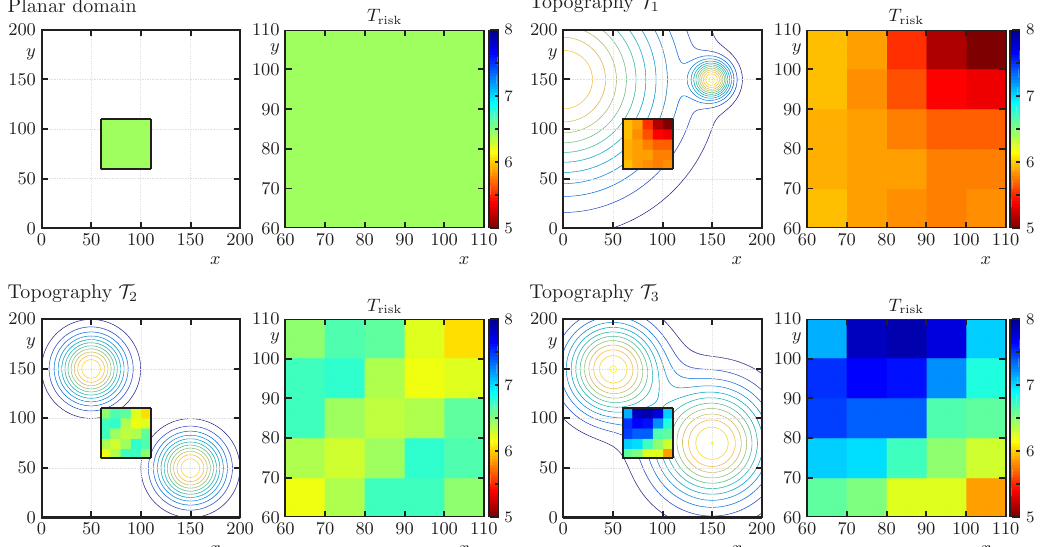
[ 60,110 ] under the assumption of × , , and (Scenarios 3.2 to 3.4, T 1 T 2 T 3 10 the final time T risk . ×